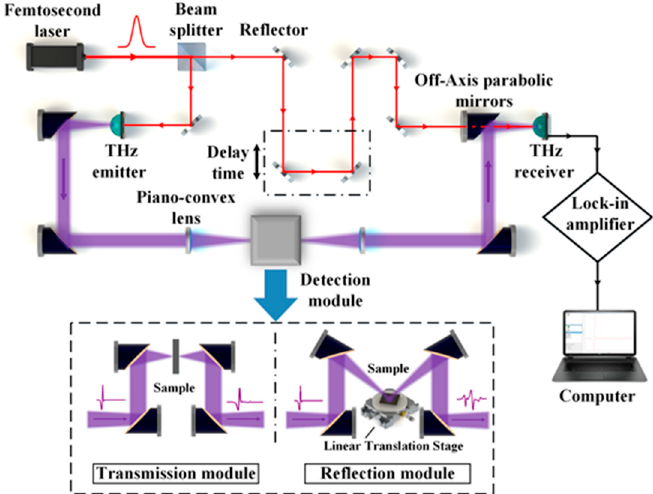
Figure 1. Schematic diagram of the terahertz time-domain spectroscopy system.